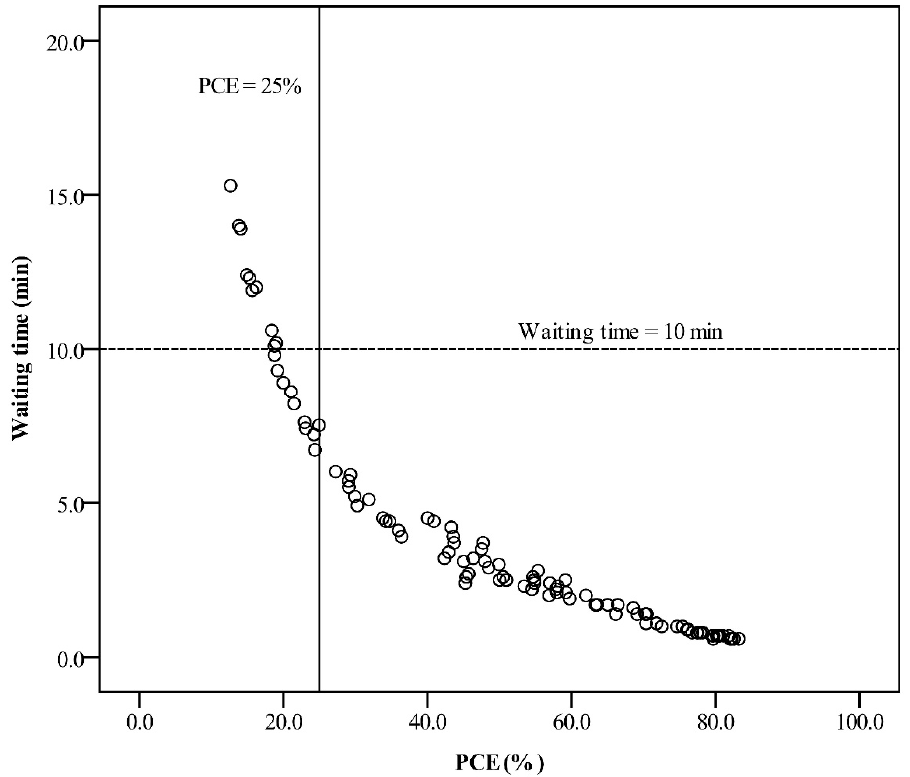
Figure 5. Plot of waiting time (minutes) against PCE (%) per month during phase 1. Vertical solid line: PCE of 25%; horizontal dashed line: waiting time of 10 min. Table 2. The indicator comparison with PCE ≧ 25% and waiting time< 10 min . PCE < 25% When WT < PCE ≥ 25% WT < 10 Min 10 Min